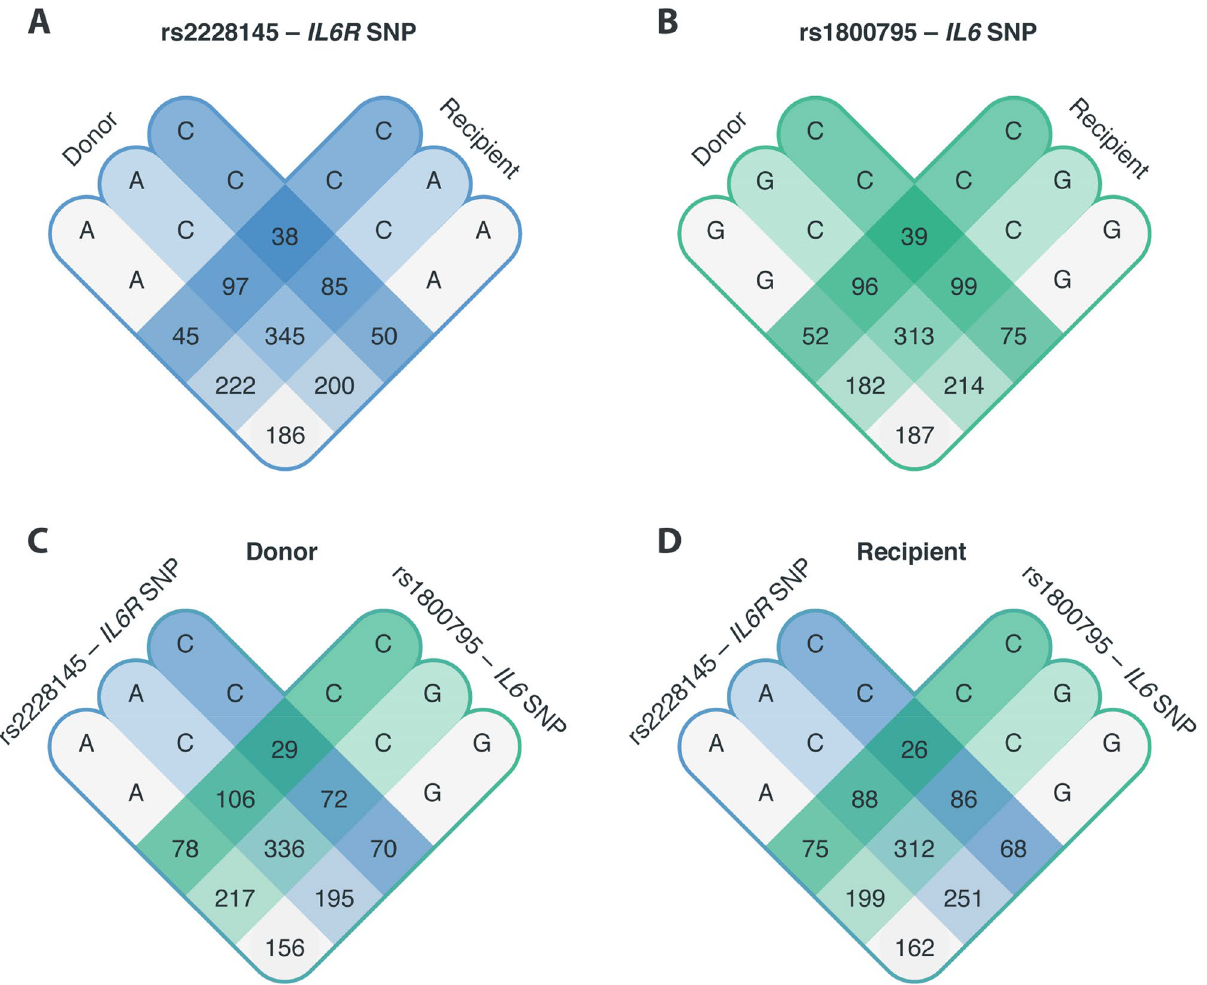
Figure 4. Venn diagram of the IL6 and IL6R genetic status of the donor, recipient and pairs. 1271 donor- recipient renal transplant pairs were analyzed for the presence of a polymorphism in interleukin-6 ( IL6 ) at position-174 in the promoter (rs1800795 G > C) and Asp358Ala variant in IL-6 receptor ( IL6R , rs2228145 A > C, previously rs8192284). The Venn diagram depicts the number of renal transplant pairs based on their ( A ) IL6R genotype or ( B ) IL6 genotype. In addition, the combined genotype of IL6 and IL6R are depicted in ( C ) the donor and ( D ) the